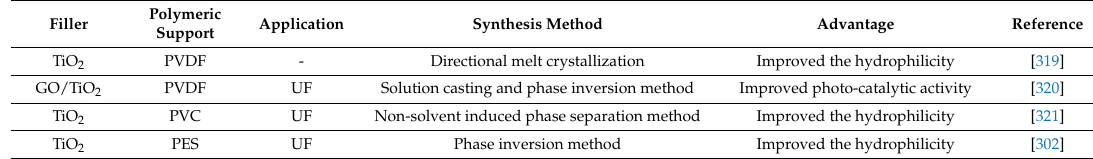
Table 6. Summary of studies on mixed matrix membranes (MMM) with different inorganic